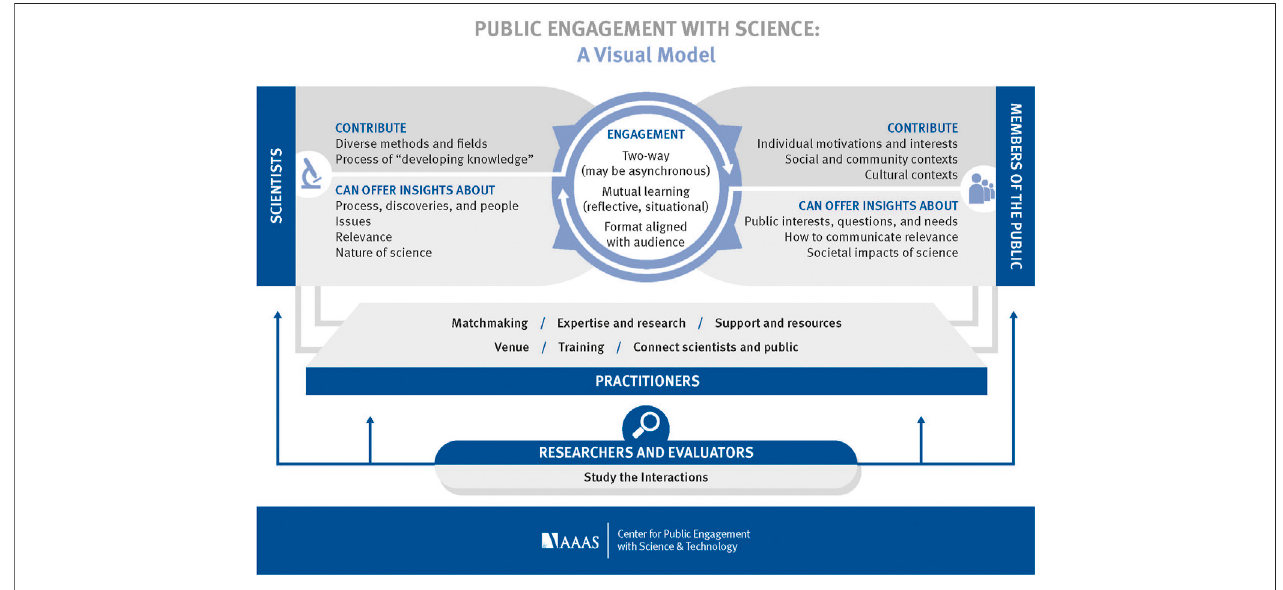
FIGURE 2 | Visual model for public engagement with science